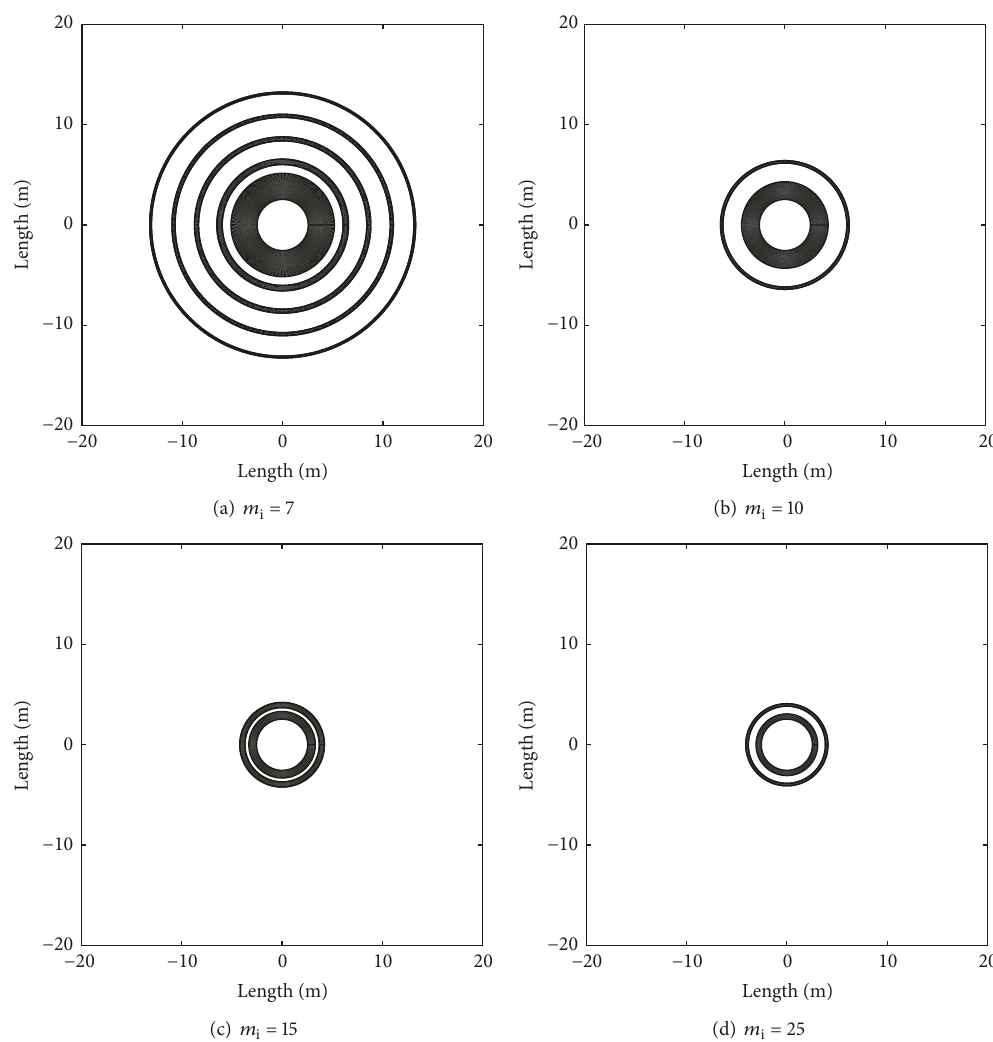
Figure 6: Effect of Hoek-Brown parameter 𝑚 i on zonal